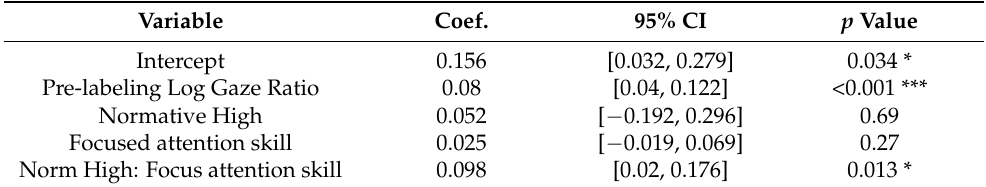
Table 3. Results for the model output from the backwards stepwise feature selection of log gaze ratio of fixations to target vs. distractor in the post-labeling test period. Variable Coef. 95%